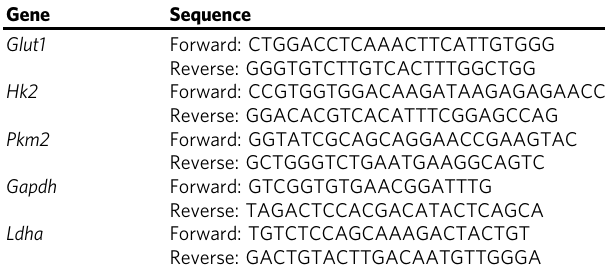
Table 3 Sequences of primers for quantitative